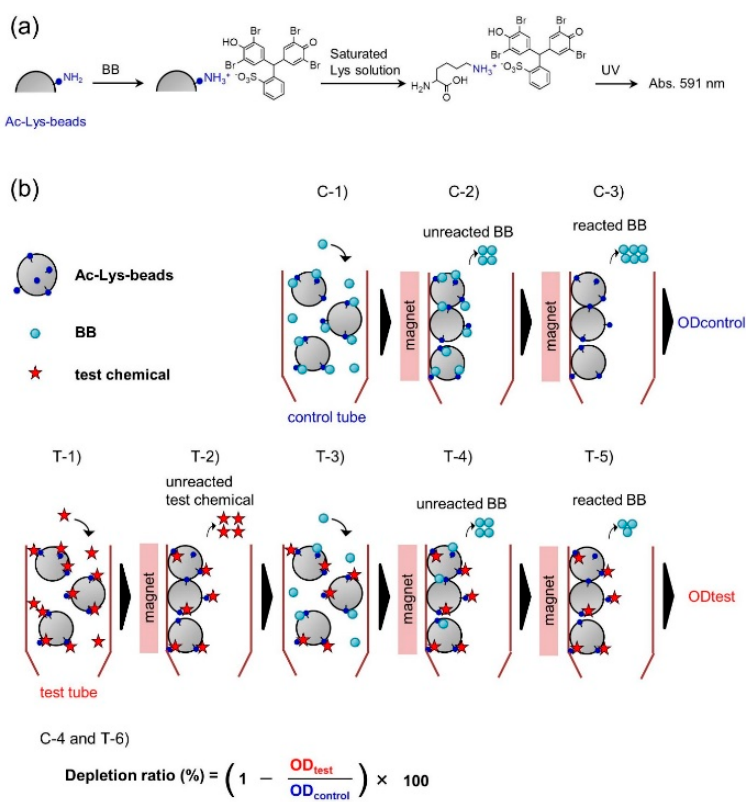
Figure 3. ( a ) C-SPRA-MB method with UV detection of bromophenol blue (BB). ( b ) Schematic representation of the procedures for using a magnet holder and separator in C-SPRA-MB and assessing skin sensitization. The procedure is as follows: (T-1) a test chemical was added; (T-2) after the reaction process (24 h), the Ac-Lys beads were washed; (C-1 and T-3) and the BB was added to Ac-Lys beads; (C-2 and T-4) the unreacted BB was removed out by washing with the solvent; (C-3 and T-5) the release solution (saturated Lys solution) was added for removal and collection of reacted chromophores, and OD control and OD test were obtained by UV measurement; (C-4 and T-6) the depletion ratio was calculated from OD control and OD test .